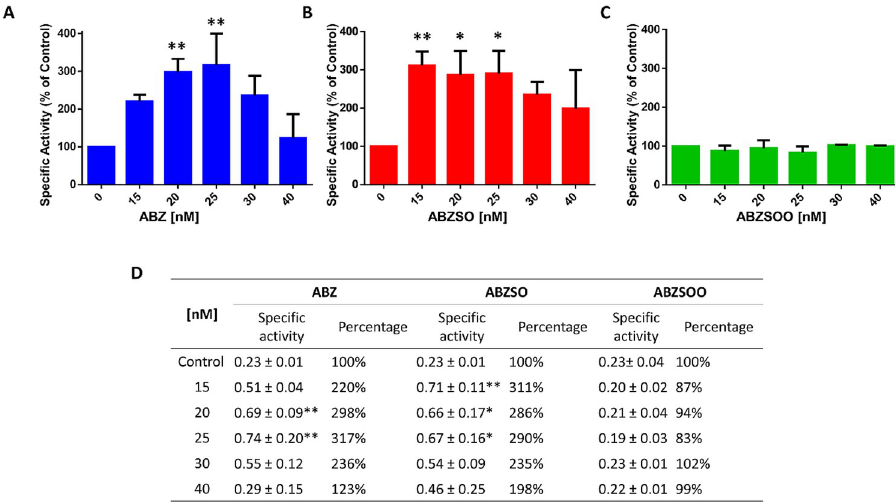
Fig 7. Relative specific activity of gFlHb in the presence of ABZ (A) and its metabolites sulfoxide (B) and sulfone (C). Enzyme activity was determined at 37˚C in 50 mM potassium phosphate pH 7.5, 160 μ M NADH, 0.65 μ M gFlHb and 1 μ M FAD was added to initiate the reaction. Values and errors (SE) shown are representative of n = 3 independent experiments (D). Absolute values of specific activities of gFlHb with ABZ, ABZSO and ABZSOO and percentage activity respect to control. The specific activity units are in μ mol/min � mg. Asterisks denote statistical significant differences ( � p < 0.05 and �� p < 0.01), as determined by ANOVA